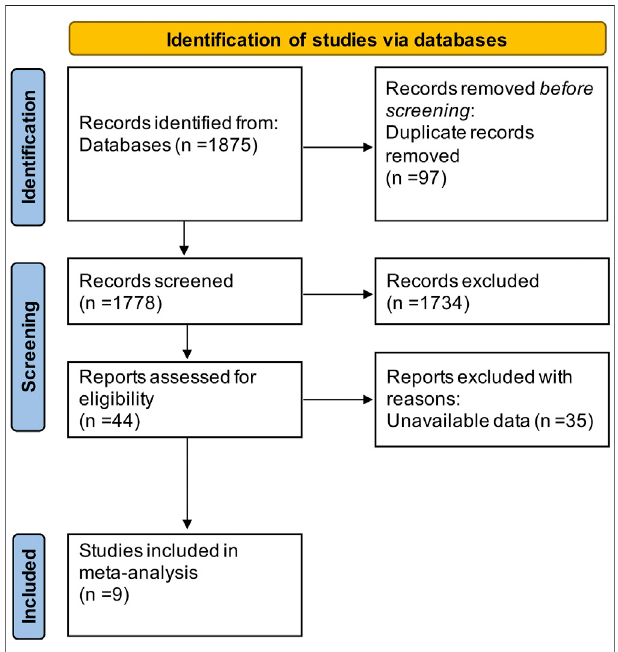
FIGURE 2 | Flow chart of studies screening.